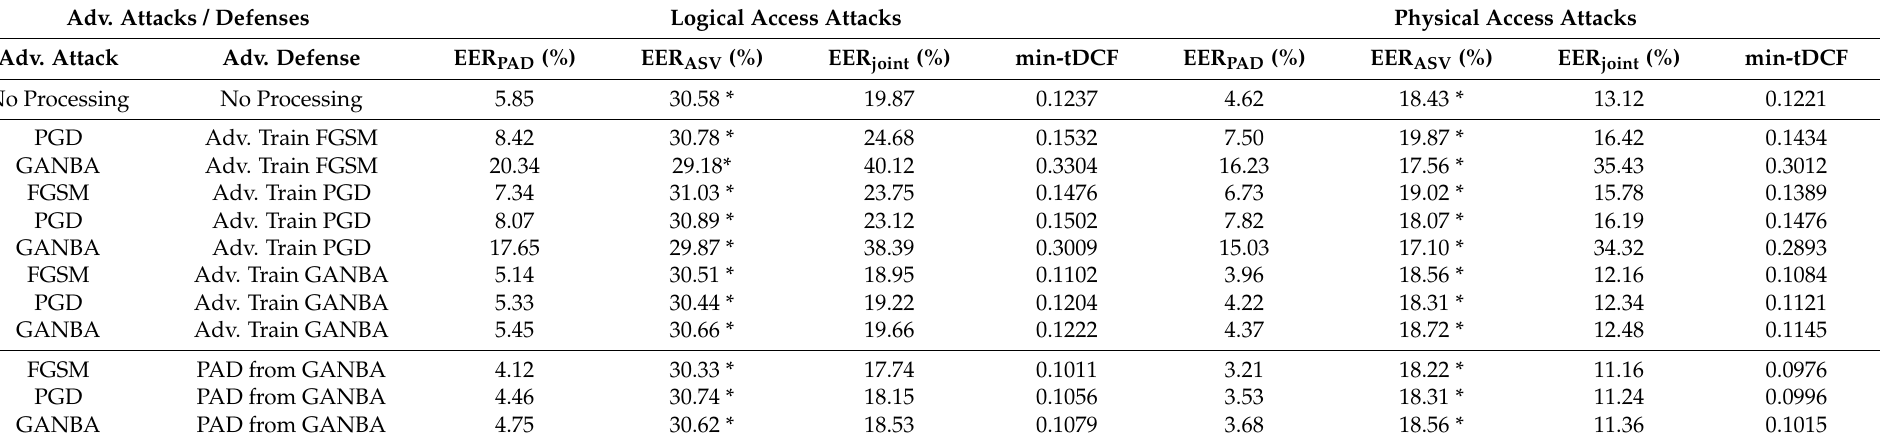
Table 2. Results of the TDNN + PLDA/LCNN biometric system evaluated on the ASVspoof 2019 logical access (LA) and physical access (PA) test datasets in terms of EER PAD (%), EER ASV (%), EER joint (%) and min-tDCF. The FGSM and PGD attacks employs their best attack configuration ( (cid:101) = 1.0). (*) The EER ASV metric is evaluated considering both bonafide and spoofing